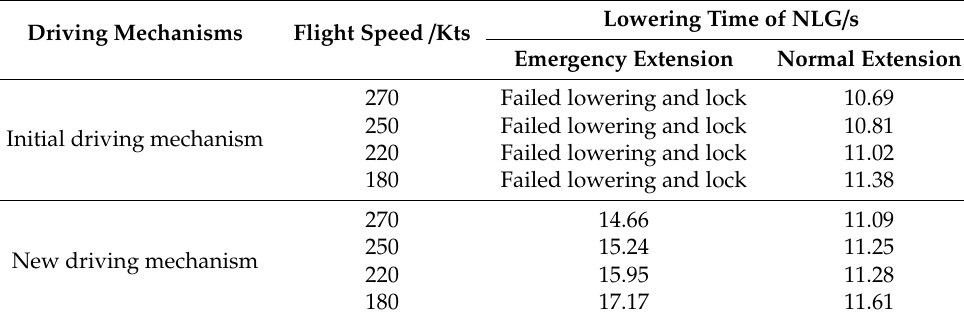
Table 5. The lowering time of the initial and new driving